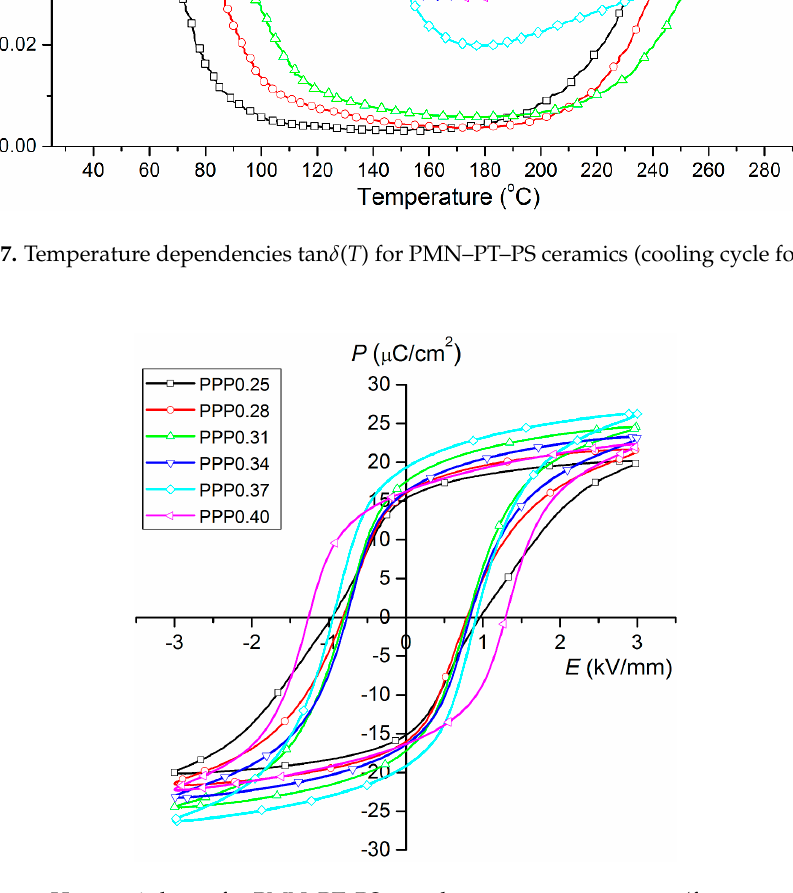
Figure 8. Hysteresis loops for PMN–PT–PS samples at room temperature (frequency 1 Hz).